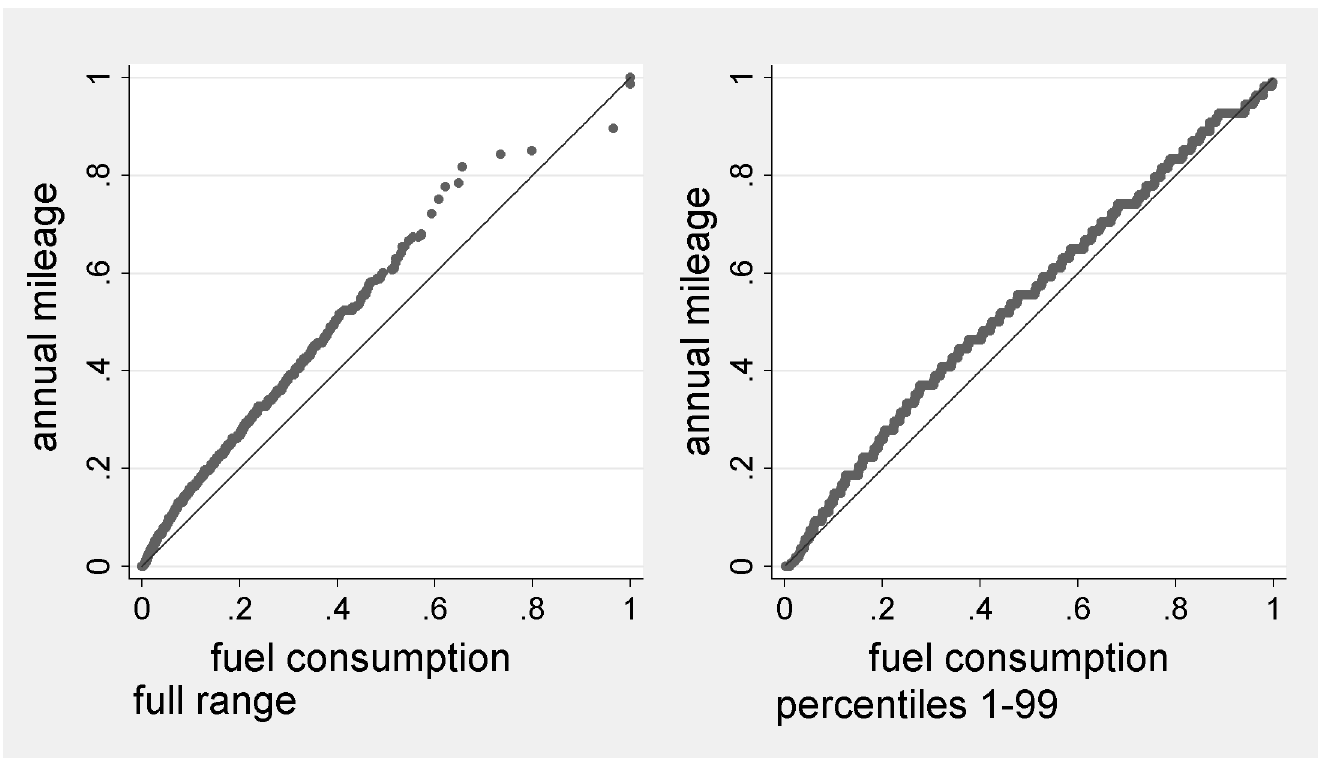
Fig 7. Quantile-quantile plots of estimated fuel consumption rates against recorded annual mileage. Note Valueshave been dividedby the maximum of the range.